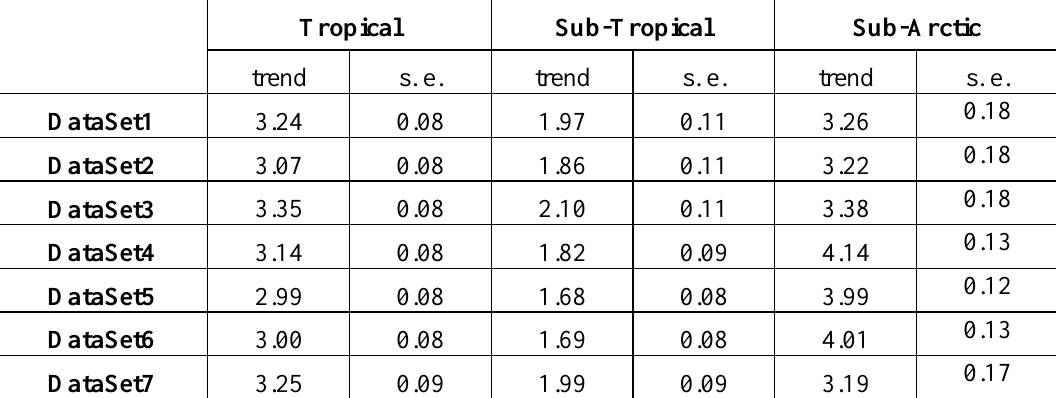
Table 3. Linear trends (mm/yr) and corresponding standard errors (mm/yr) obtained by OLS fit to the time series of the interannual SLA signal.